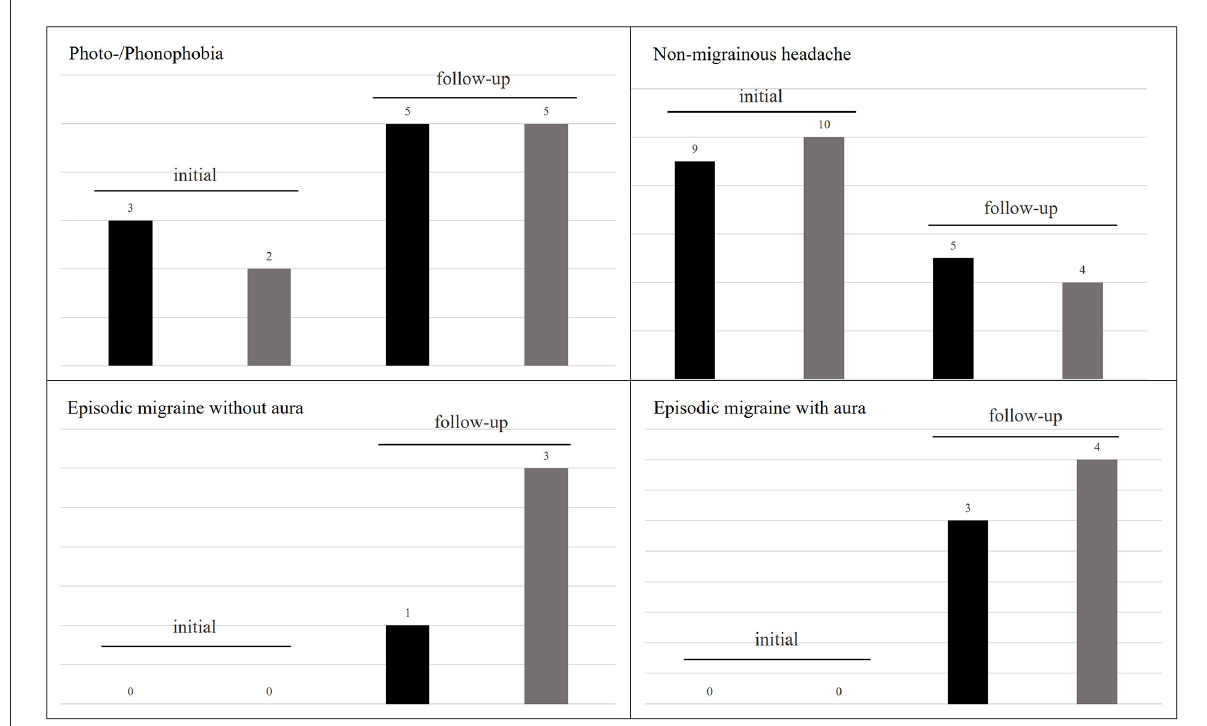
FIGURE3 Frequency of headaches and associated symptoms in RVC at initial and follow-up examination. Photo-/phonophobia increased over the course of the disease, while non-migrainous headaches decreased. However, seven patients developed an episodic migraine. The black columns represent patients reporting this symptom during and the gray columns outside of vertigo